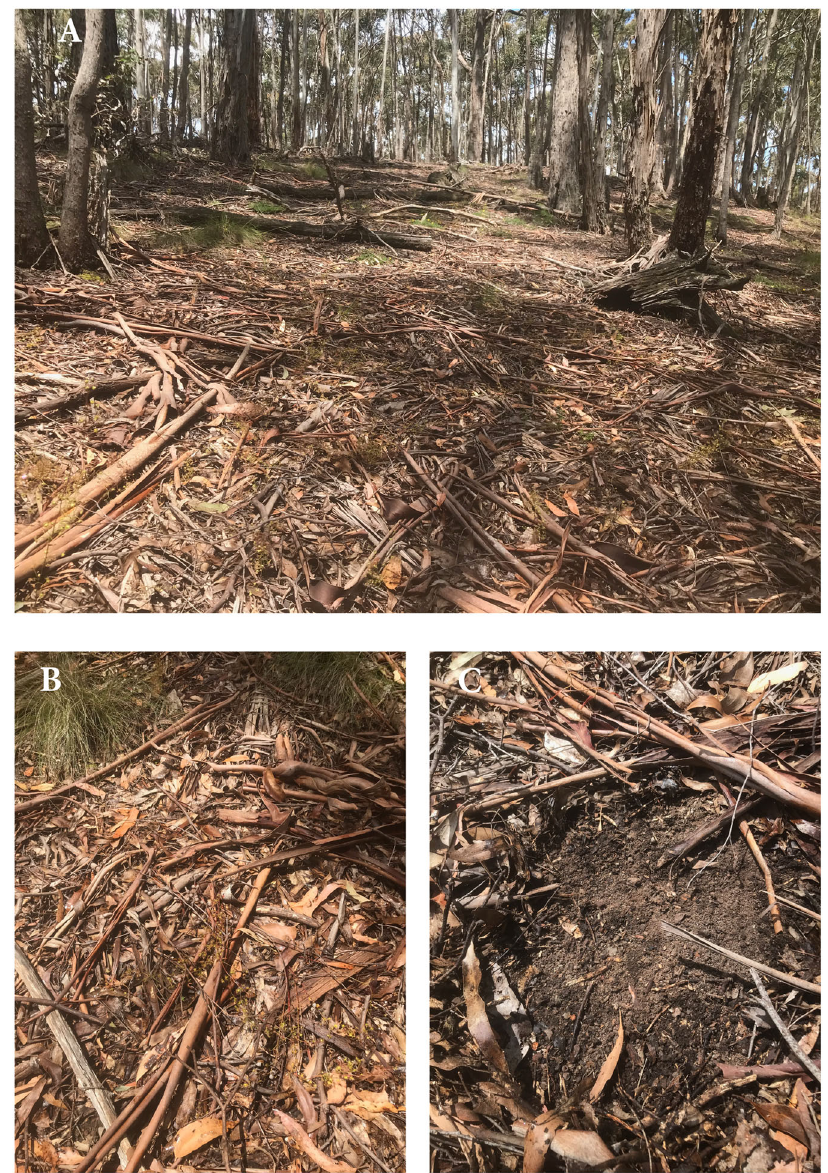
Fig. 7 | Litter accumulation in long unburnt Wombat Forest, near Daylesford, Vic. A This forest is dominated by Eucalyptus rubida (Candlebark) along with E. radiata (Narrow leaf peppermint). B Shed bark and twigs decompose much more